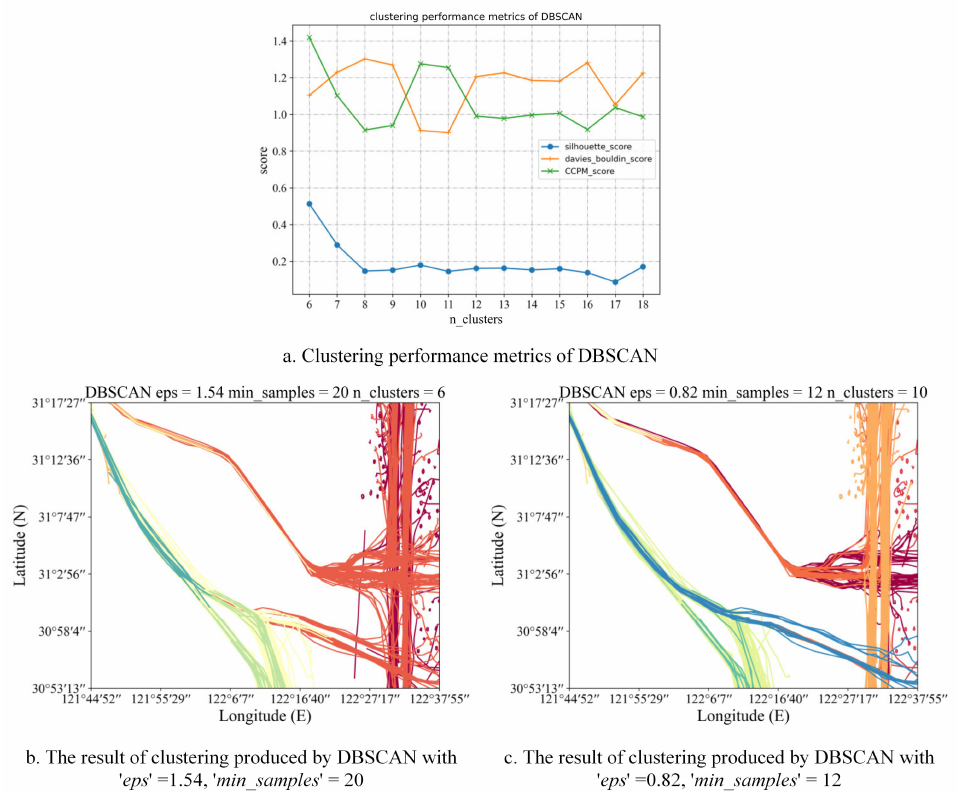
Figure 12. Clustering performance of DBSCAN clustering with different